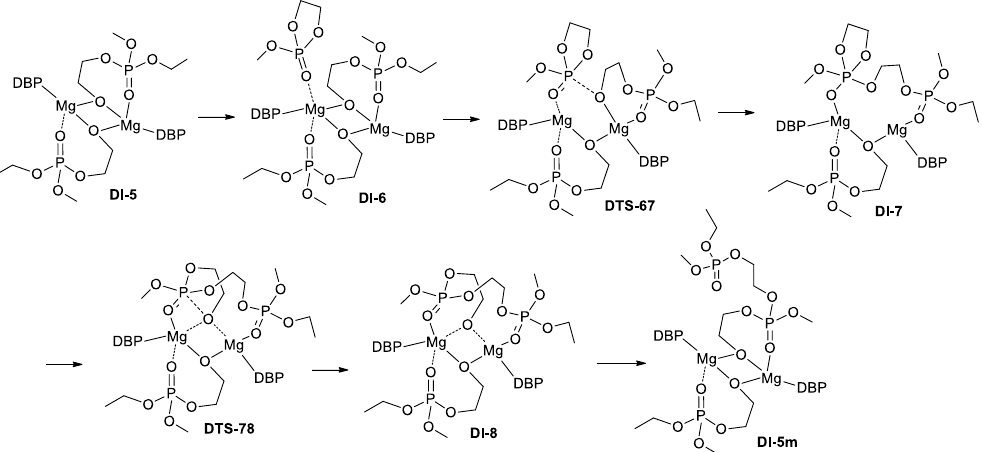
Table 2. Calculated ∆ G DI-1 and ∆ H DI-1 values for the key intermediates and transition states for the binuclear mechanism of MeOEP polymerization.